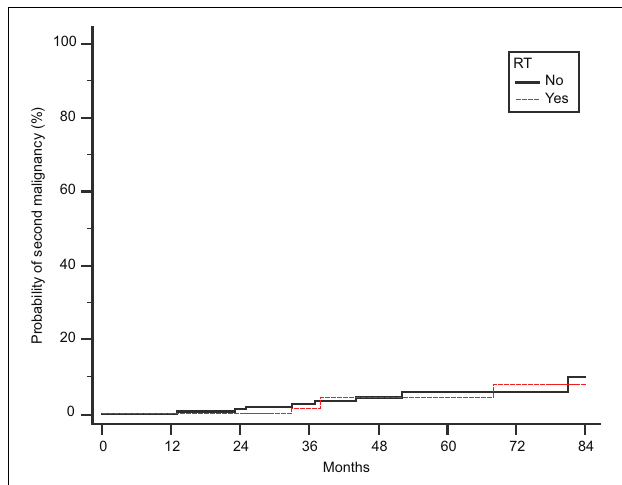
FIGURE 2 | Cumulative probability of second malignancy .Time to develop a second malignancy is calculated from the initial diagnosis of